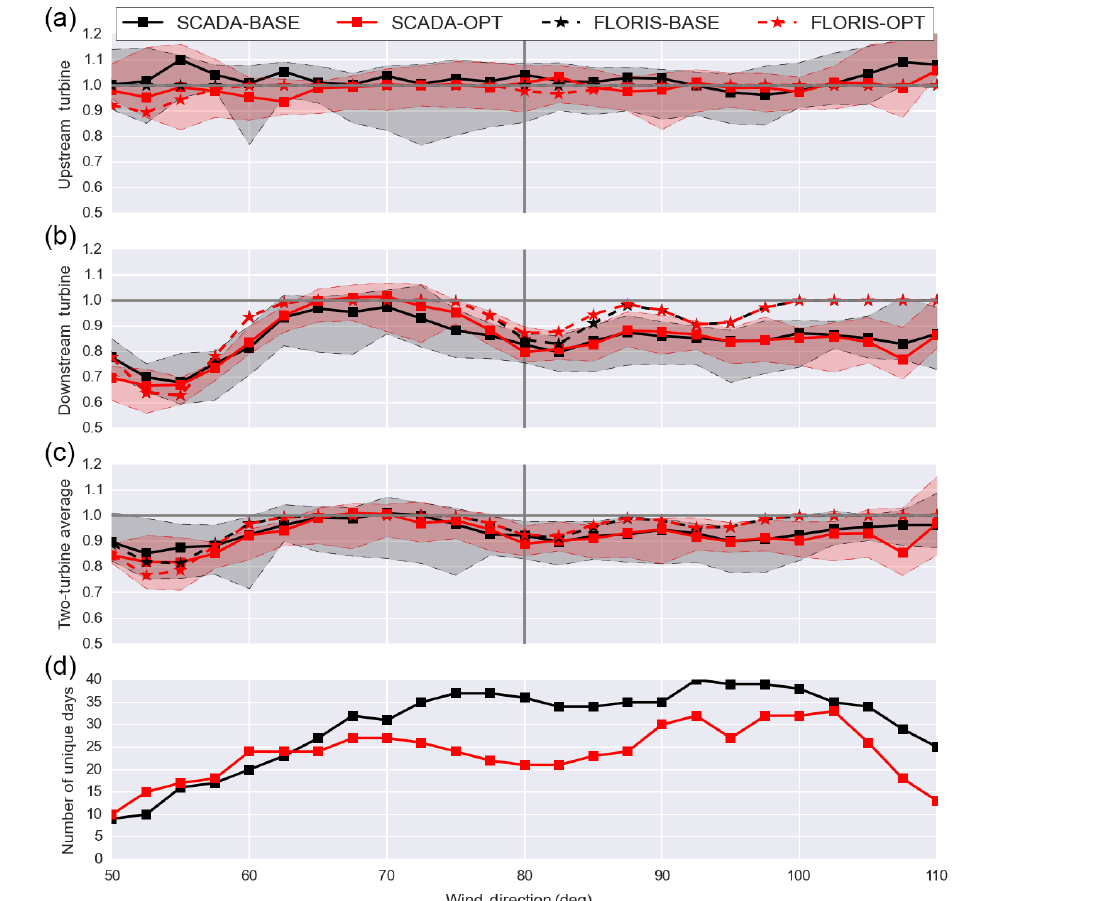
Figure 8. This figure shows the results of the turbine C1 to turbine D3 pair. In particular, (a) shows turbine C1 and the resulting power with the controller on (red) and off (black). Panel (b) shows the downstream turbine, i.e., turbine D3, with the controller on (red) and off (black). Panel (c) shows the overall power between the pair of turbines. There is no noticeable power gain with the controller on or off. This is likely because of the increase in spacing between turbines C1 and D3 (14.3D) in comparison to the spacing between turbine C1 and D1 (7D). Finally, (d) indicates the number of days used to compute the statistics provided in the top three